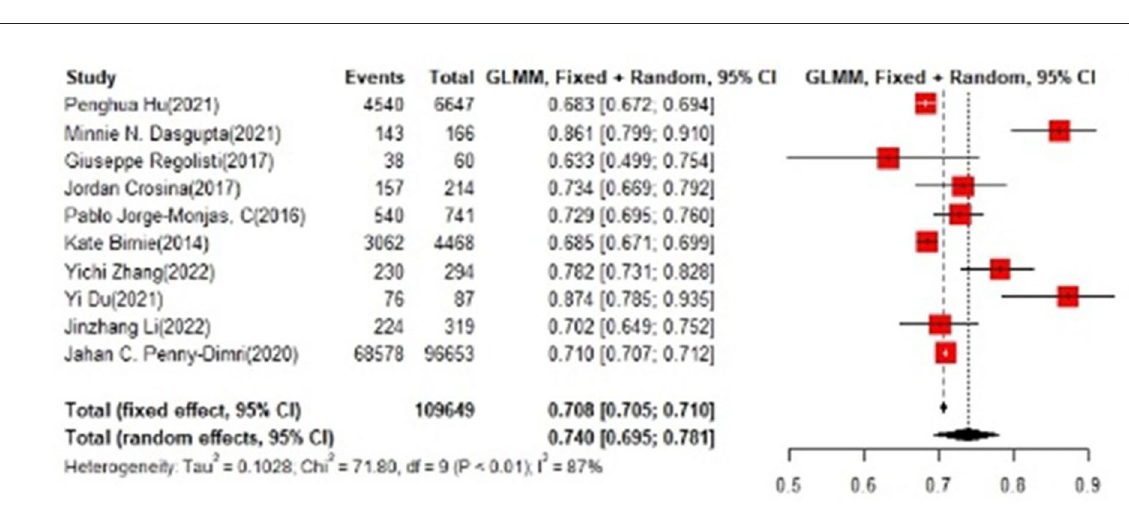
FIGURE5 Accuracy of the machine learning-based model in the test set: logistic